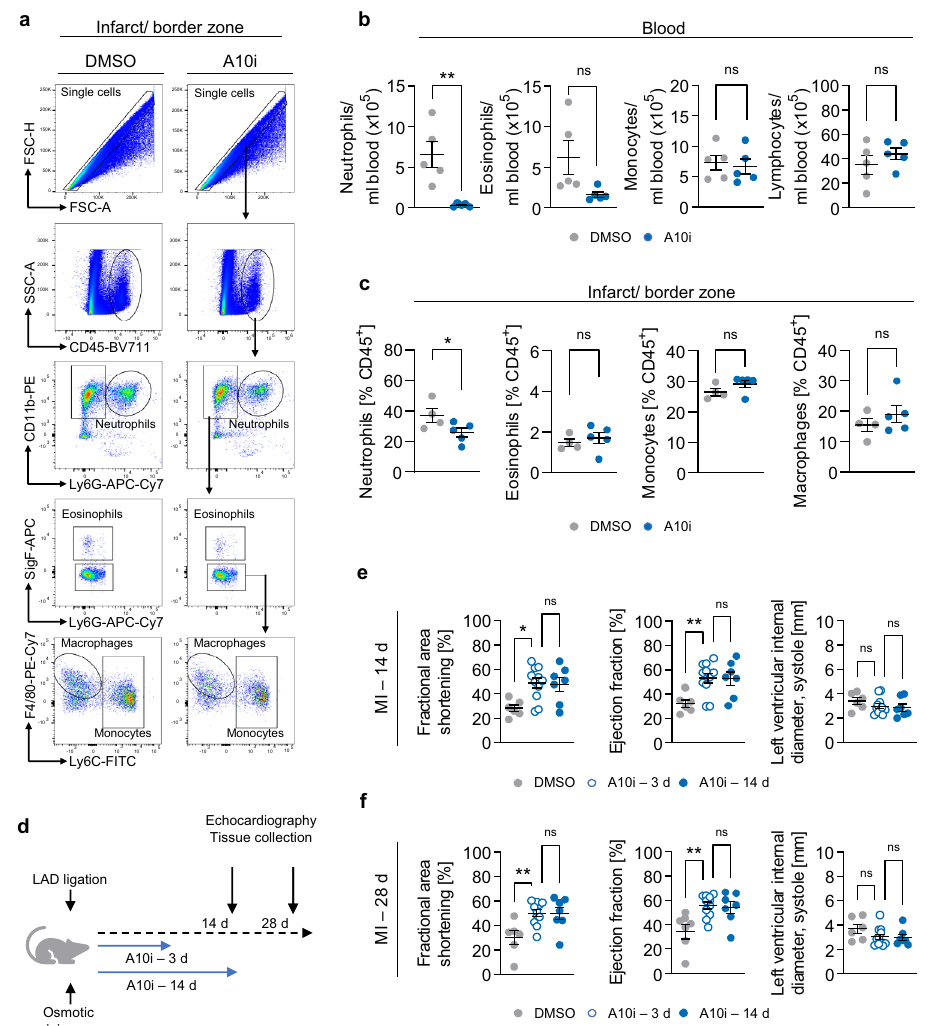
Fig. 4 | ADAM10 inhibition reduces neutrophil bone marrow egress and heart tissue in fi ltration following myocardial infarction. a Gating strategy for identi- fi cation of neutrophils (CD45 + , CD11b + , Ly6G + ), eosinophils (CD45 + , CD11b + , Ly6G − , SigF + ), monocytes (CD45 + , CD11b + , Ly6G − , SigF − , F4/80 − , Ly6C + ) and macrophages (CD45 + , CD11b + , Ly6G − , SigF − , F4/80 + ) in the infarcted area/ infarct border zone of A10i ( n =5) and DMSO ( n =4) treated mice 3 days after infarction. b Analysis of leukocyte counts in blood samples of GI254023X (A10i, n =5) and DMSO ( n =5) treatedmice3daysafterinfarction(mean±SEM, nsnotsigni fi cant,** P